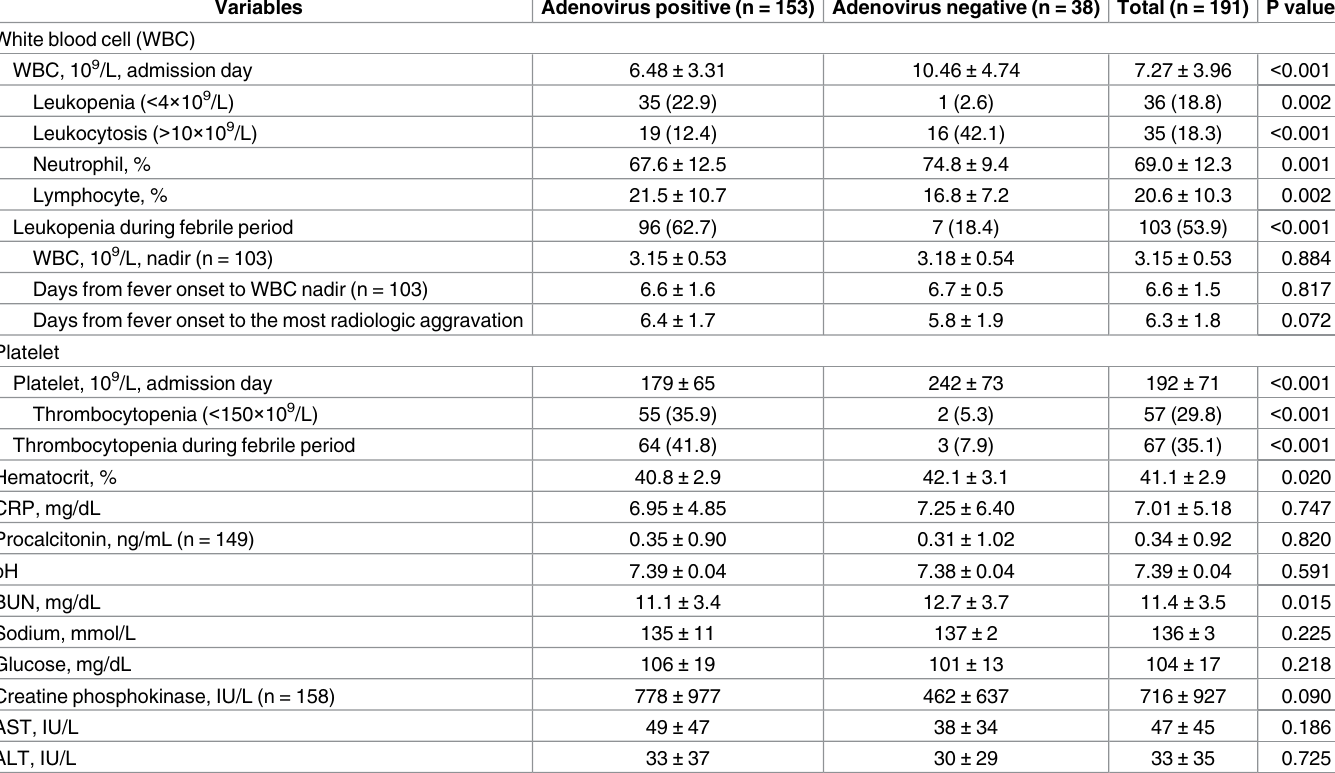
Table 3. Laboratory findings of 191 patients with community-acquired pneumonia in the military.